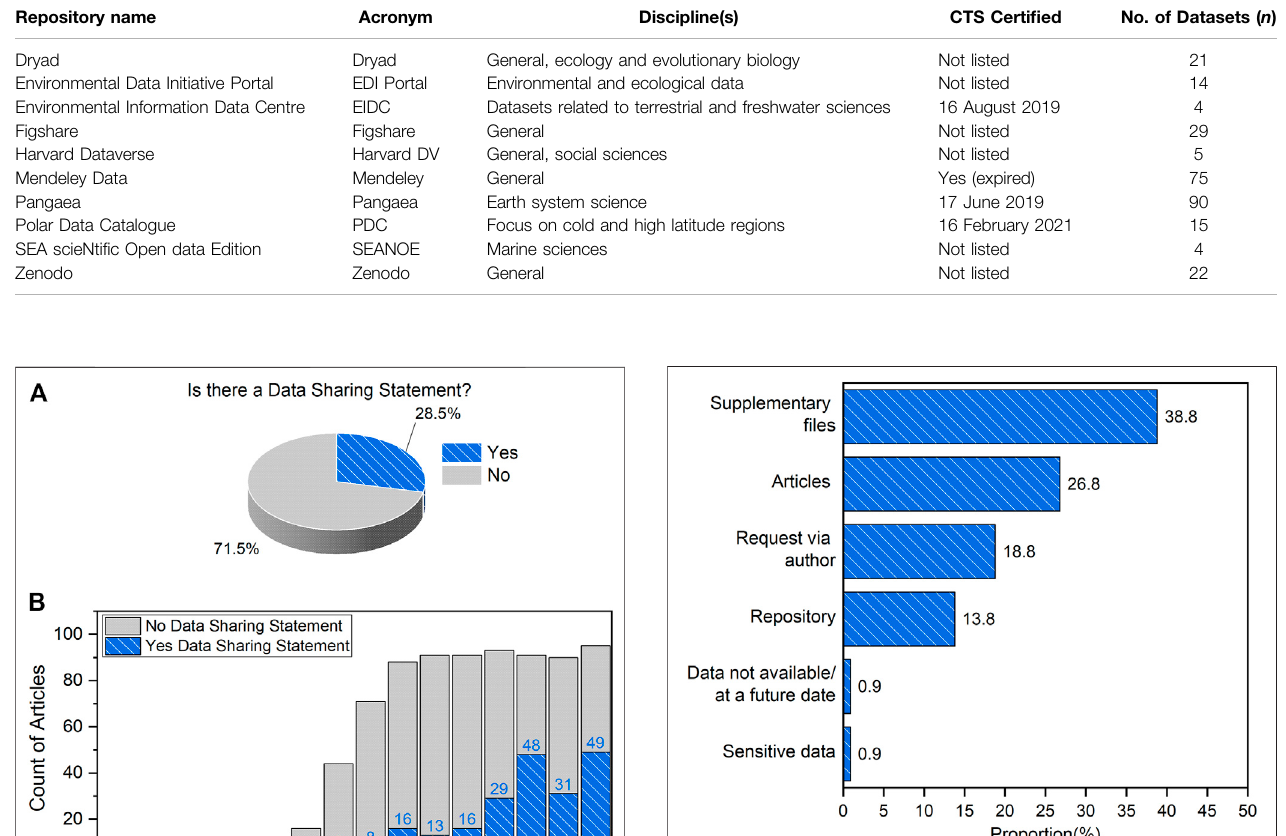
TABLE 2 | Selected research data repositories used in this study.